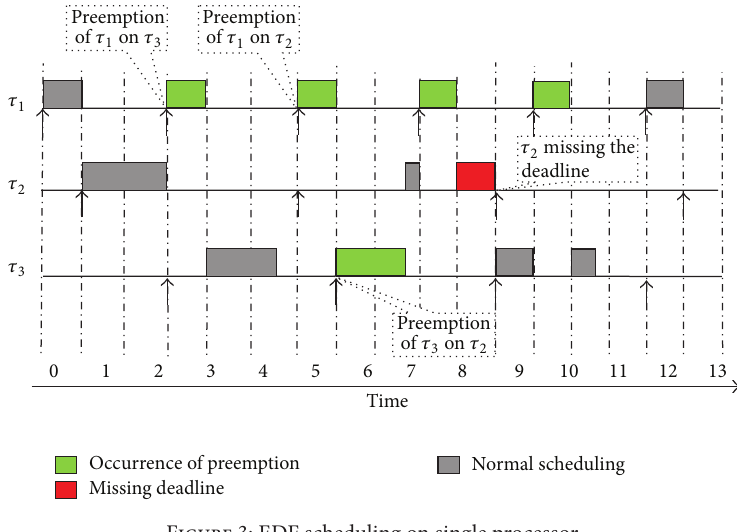
Figure 3: EDF scheduling on single processor.